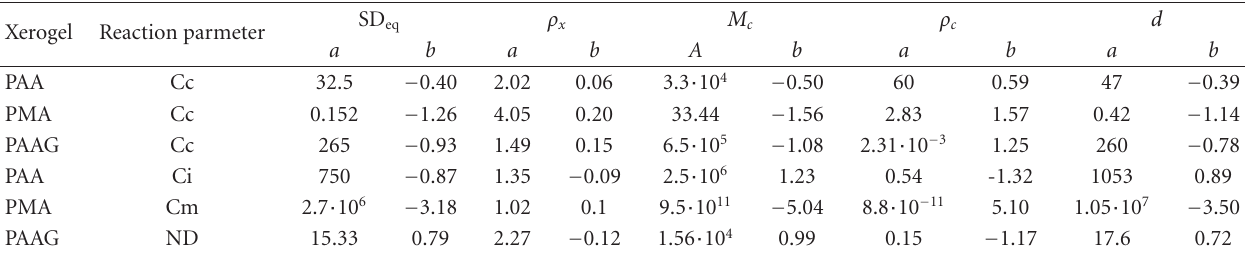
Table 7: The values of prefactor and exponent for established power function of the MP PSP on di ff erent reaction conditions. Xerogel